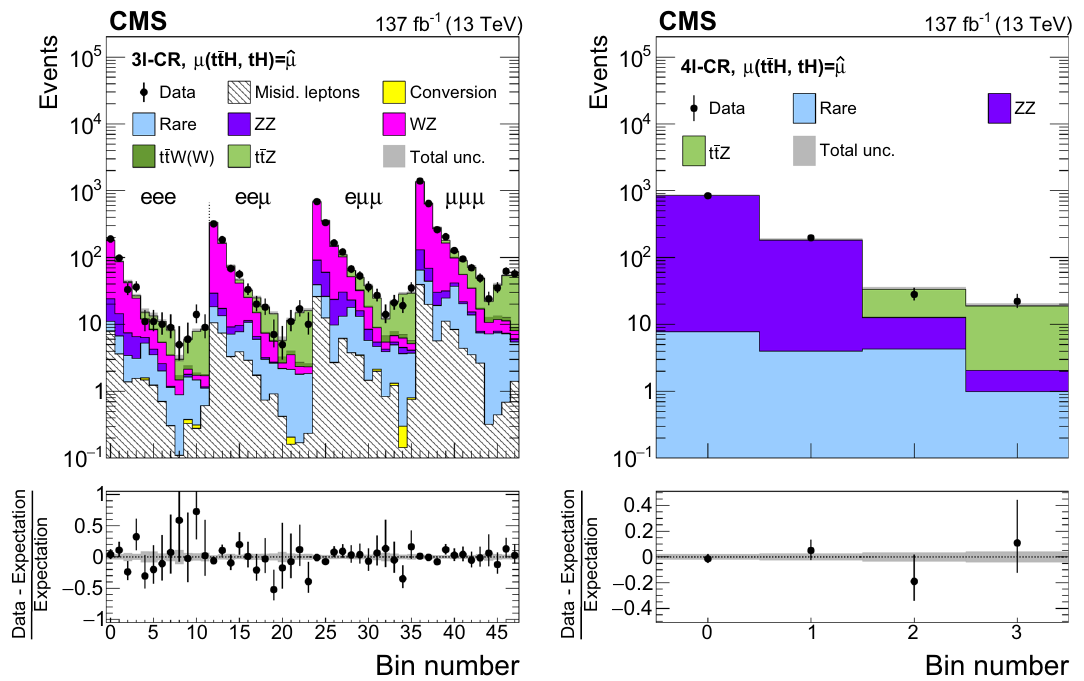
Fig. 12 Distributions of discriminating observables in the 3 (cid:4) + 0 τ h (left) and 4 (cid:4) + 0 τ h (right) control region. The distributions expected for the ttH and tH signals and for background processes are shown for the values of the parameters of interest and of the nuisance parameters